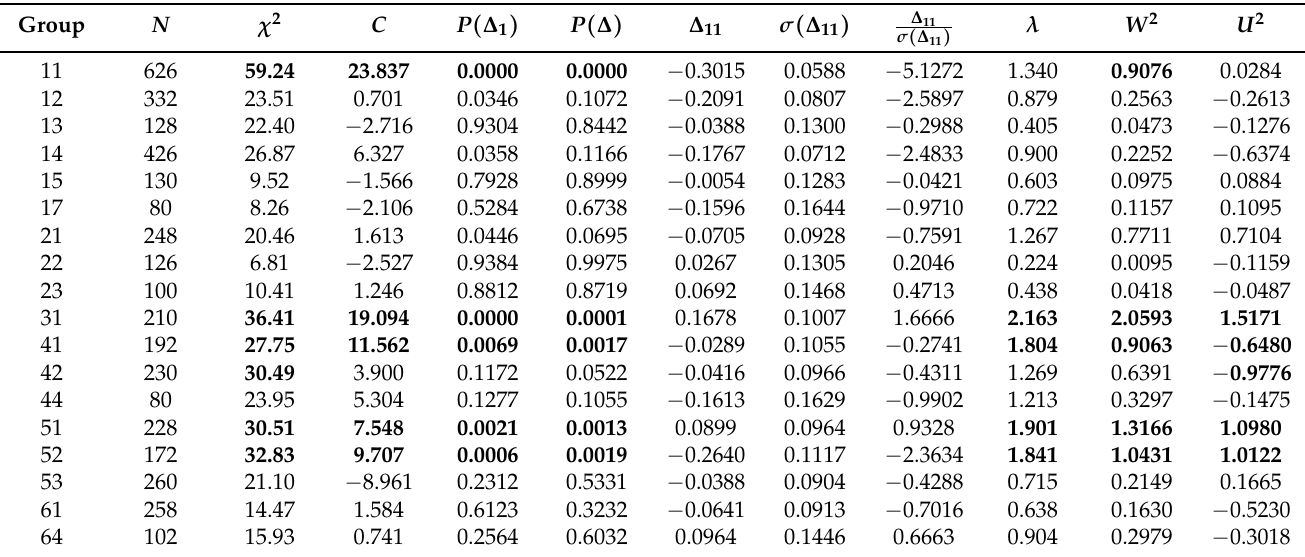
Table 11. Test for isotropy of the orientations of the galaxy plane. The distribution of the angle δ D of galaxies was obtained using the new “theoretical isotropic distribution” calculated for q 0 , depending on the morphological type.